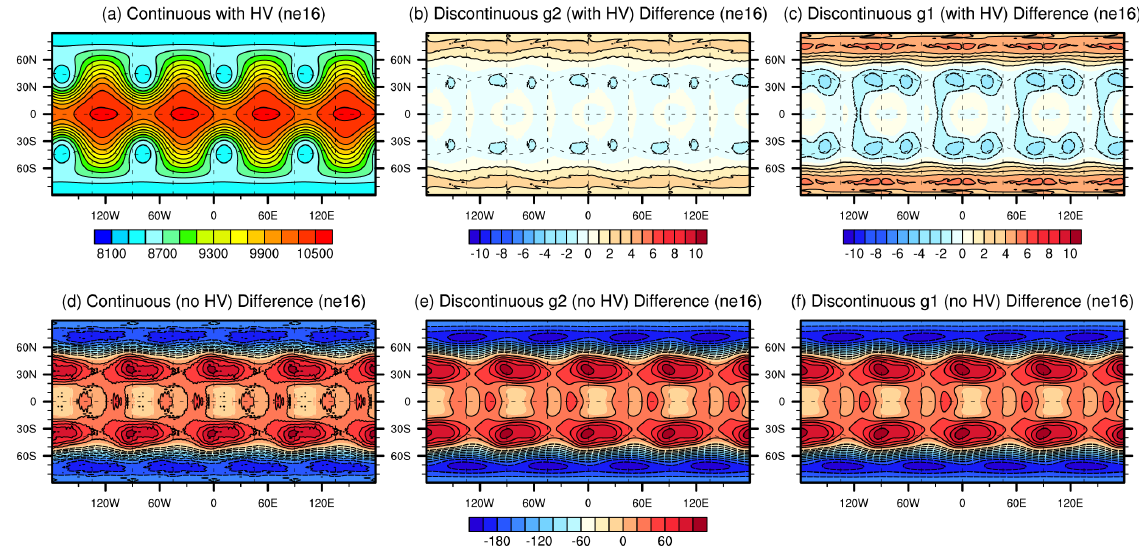
Figure 8. Height field with n e = 16 and n p = 4 at day 14 for the Rossby–Haurwitz wave with (a) continuous elements and hyperviscosity (reference solution). Height difference plot from reference solution with n e = 16 at day 14 for (b) discontinuous g 2 elements with hyper- viscosity, (c) discontinuous g 1 elements with hyperviscosity, (d) continuous elements without hyperviscosity, (e) discontinuous g 2 elements without hyperviscosity and (f) discontinuous g 1 elements without hyperviscosity. The time step used for these runs was (a, d) (cid:49)t = 480 s, (b, e) (cid:49)t = 200s and (c, f) (cid:49)t = 120s. Discontinuous penalization was used for both discontinuous schemes. Contour spacing is 1m in plots (b) and (c) and 20m in plots (d) , (e) and (f) . Long dashed lines show the cubed-sphere